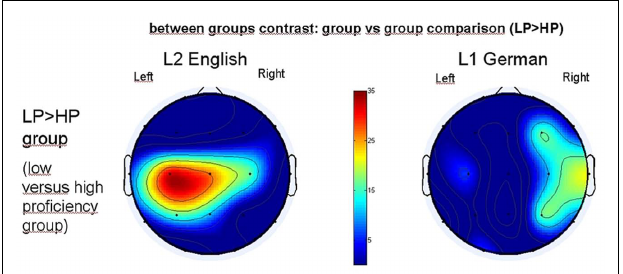
FIGURE 5 | Between groups contrast of the groups depicted in Figure 4. Shown here: LP (low proficiency group) > HP (high proficiency) group. Red color in color bar indicating which electrodes increase more their percentage of pertinence to the strongly synchronized cluster. Left panel: group contrast (indicting LP group) during L2 processing and right panel indicating L1.